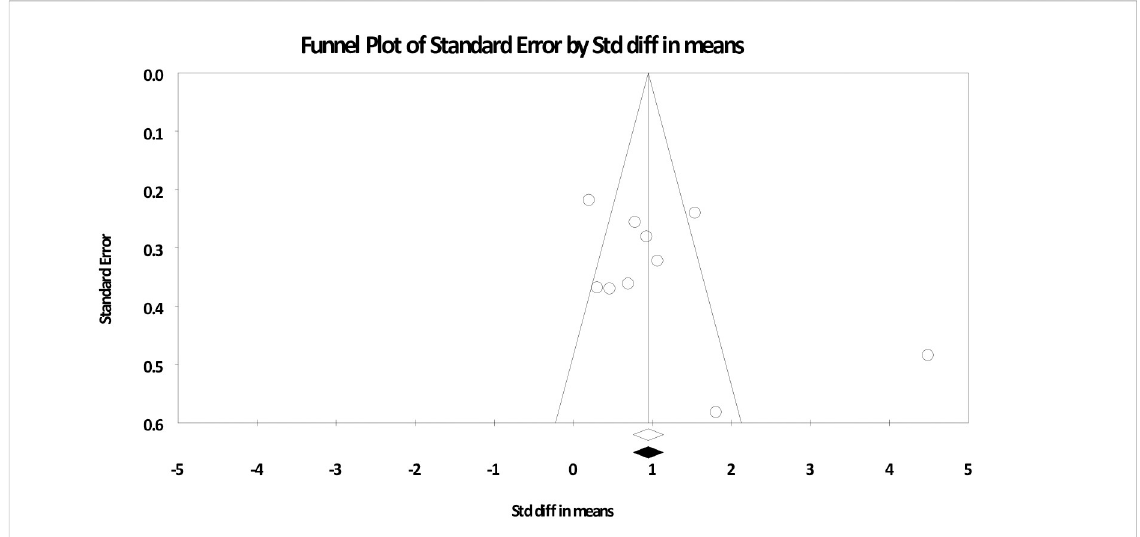
Fig 6. Funnel plot based for main analysis of trauma-focused treatments for depression compared to control conditions at post-test.